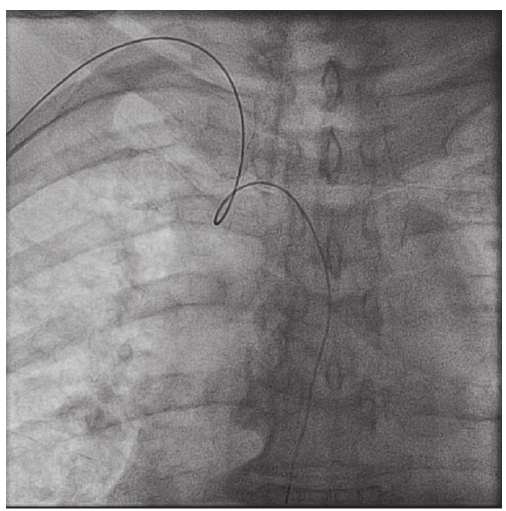
Figure1:CoilingoftheGuidewireatthejunctionofbrachiocephalic artery and aorta.